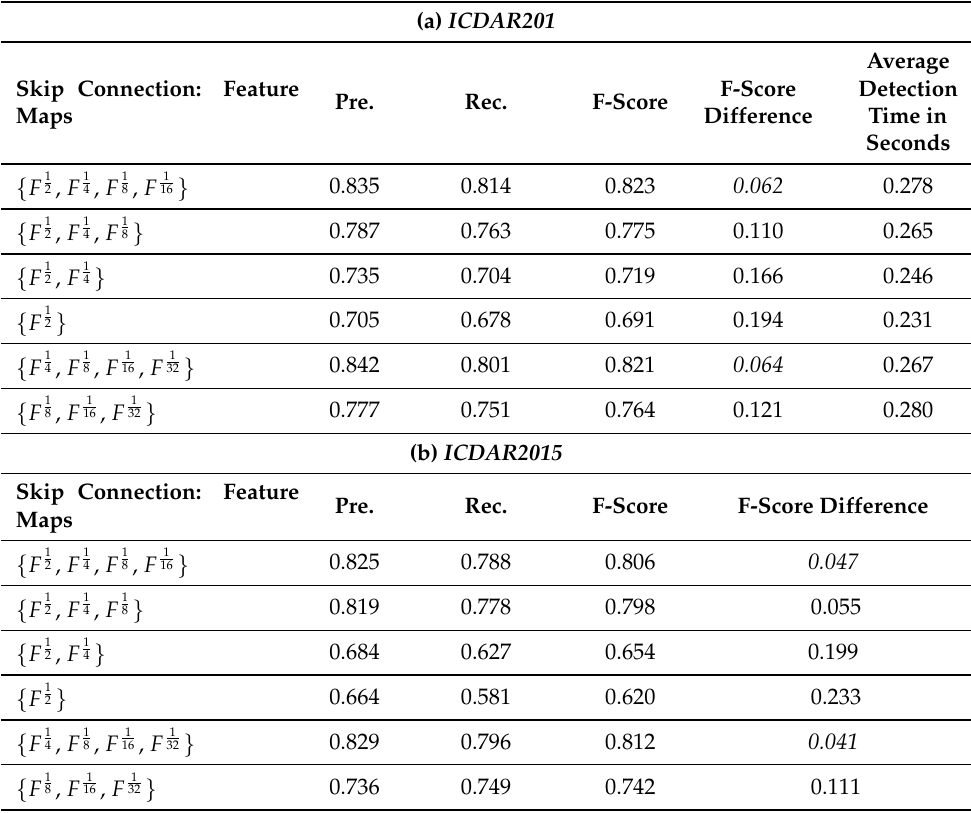
Table 4. Analysis of skip connections on ICDAR2013 and ICDAR2015